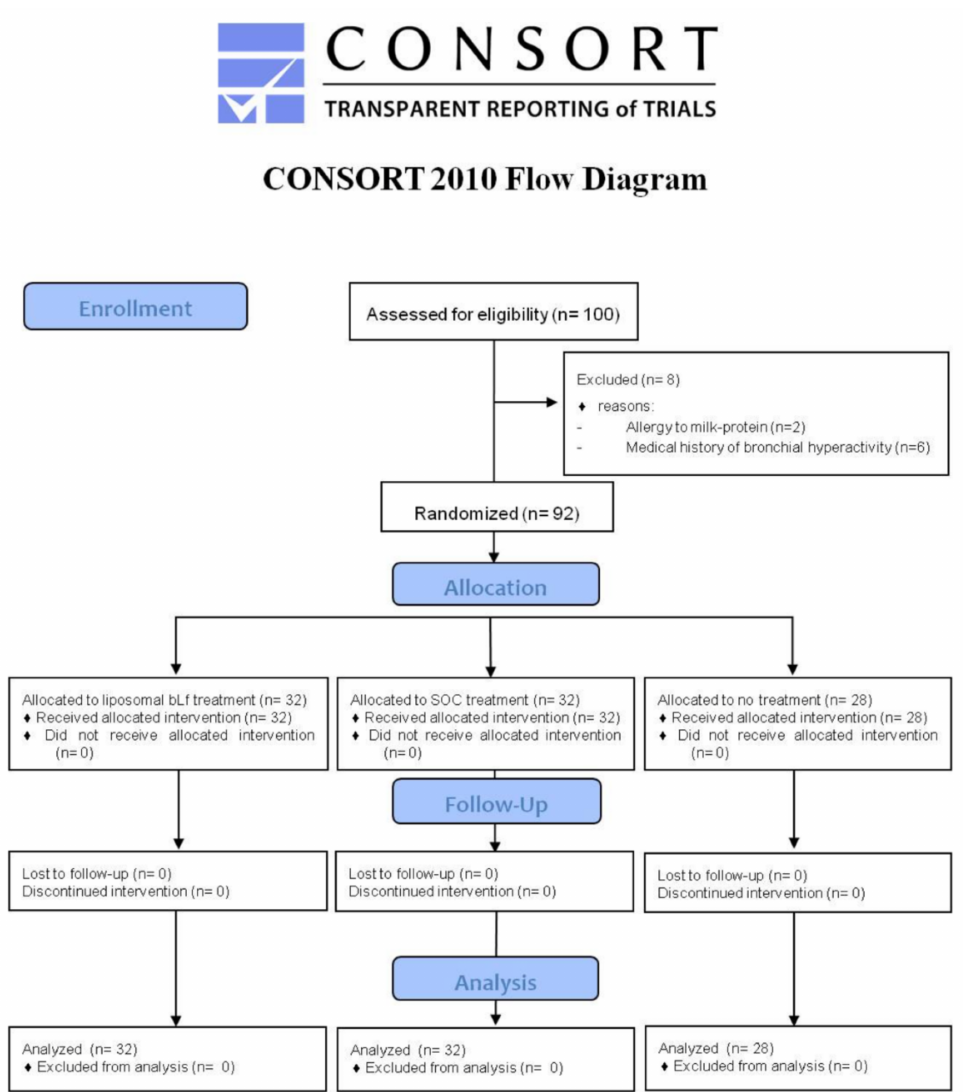
Figure 1. CONSORT diagram of the clinical trial. BLf = bovine lactoferrin; SOC = standard of